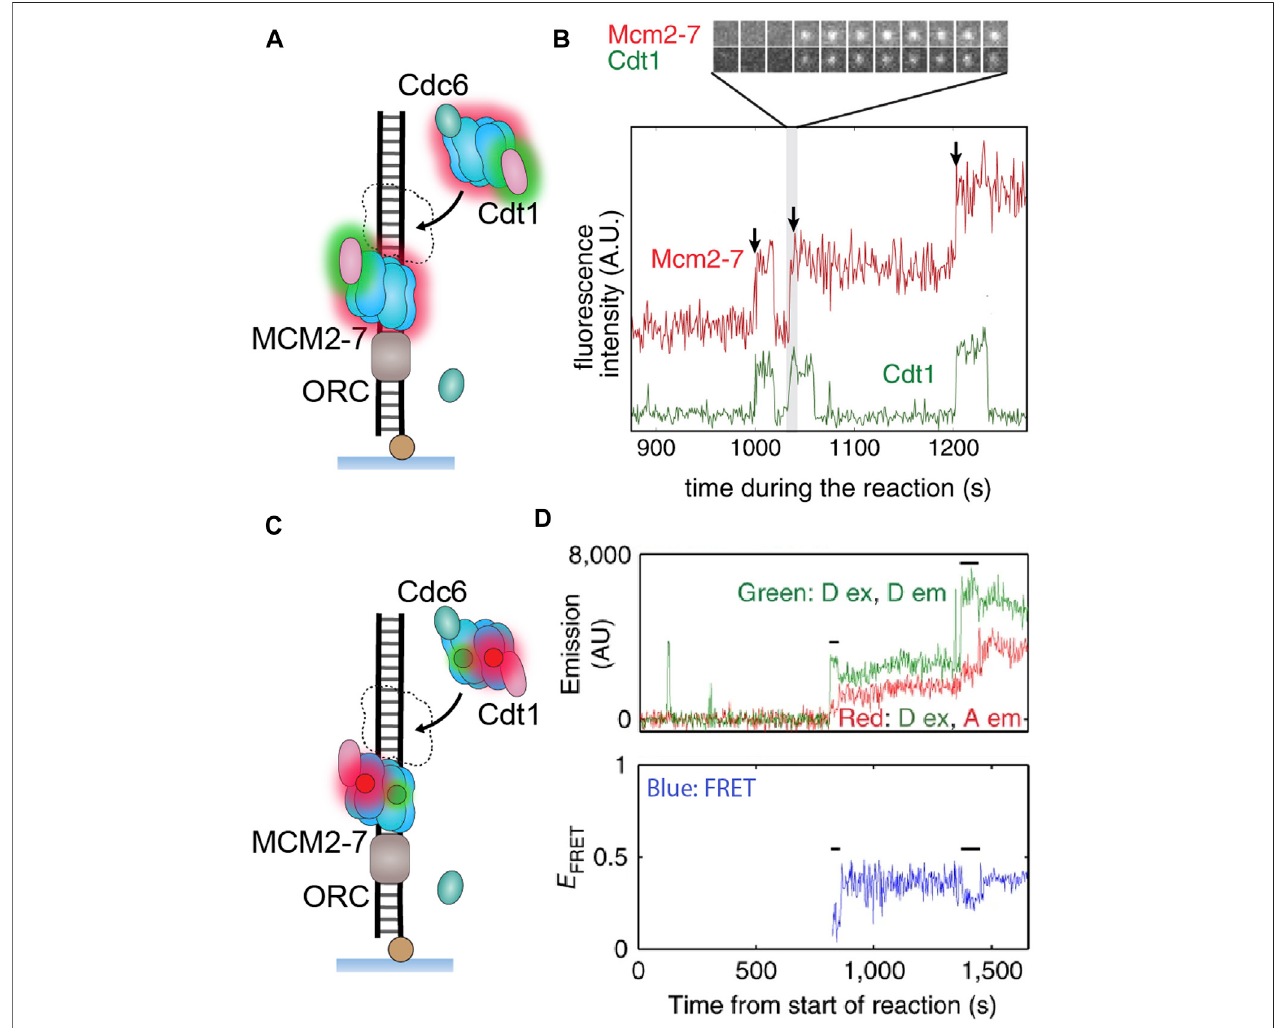
FIGURE 6 | Single-molecule visualization of CMG assembly during S. cerevisiae replication initiation. (A) A single-molecule assay where two-color colocalization is used to detect CMG loading in vitro . (B) Fluorescently labeled MCM2 – 7 (red) binds simultaneously with Cdt1 (green), with multiple hexamers appearing tobindsequentially(Ticauetal.,2015). (C) Asingle-moleculeassaywhereFRETisusedtodetectMCM2 – 7ringopeningandclosing. (D) Observationofbothdonorand acceptor emission identi fi es when MCM2 – 7 binds DNA. The FRET ef fi ciency indicates the hexameric ring state, where high FRET denotes a closed ring and low FRET denotes an open ring. Instances of low FRET (black lines) correlate with MCM2 – 7 binding, indicating that the ring brie fl y opens as it encircles DNA during loading (Ticau et al., 2017).